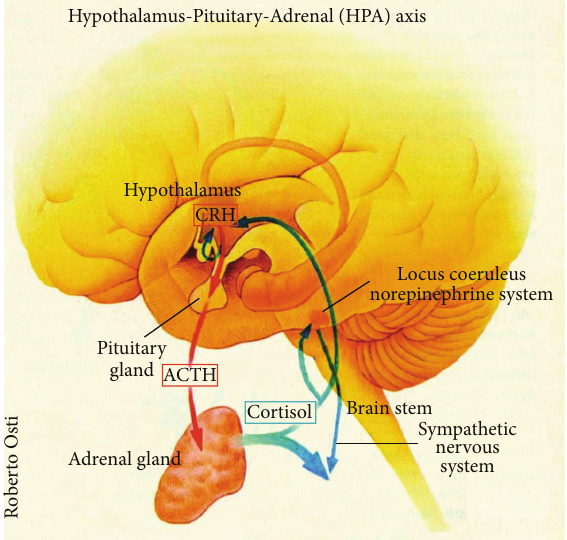
Figure 1: The Hypothalamus-Pituitary-Adrenal (HPA) axis. CRH = corticotropin-releasing hormone; ACTH = adrenocorticotropic hormone